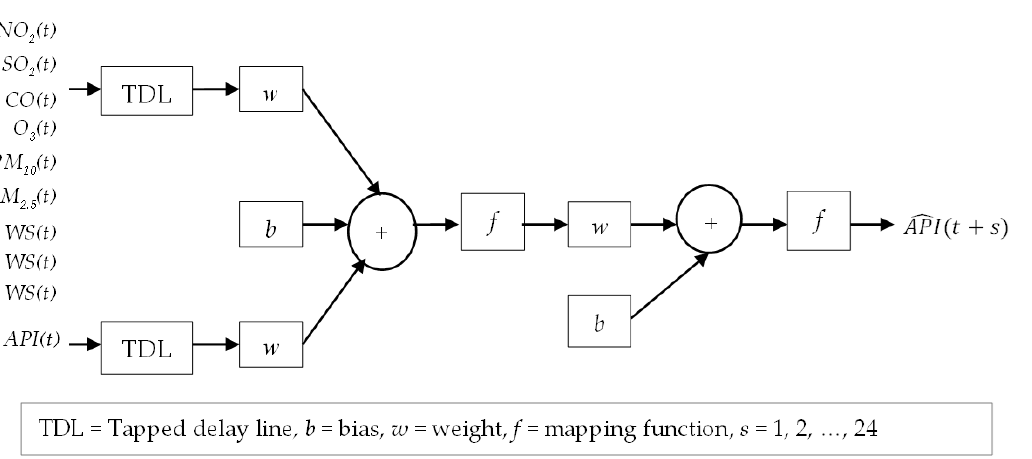
Figure 3. The NARX model for s-multi-step predictions.